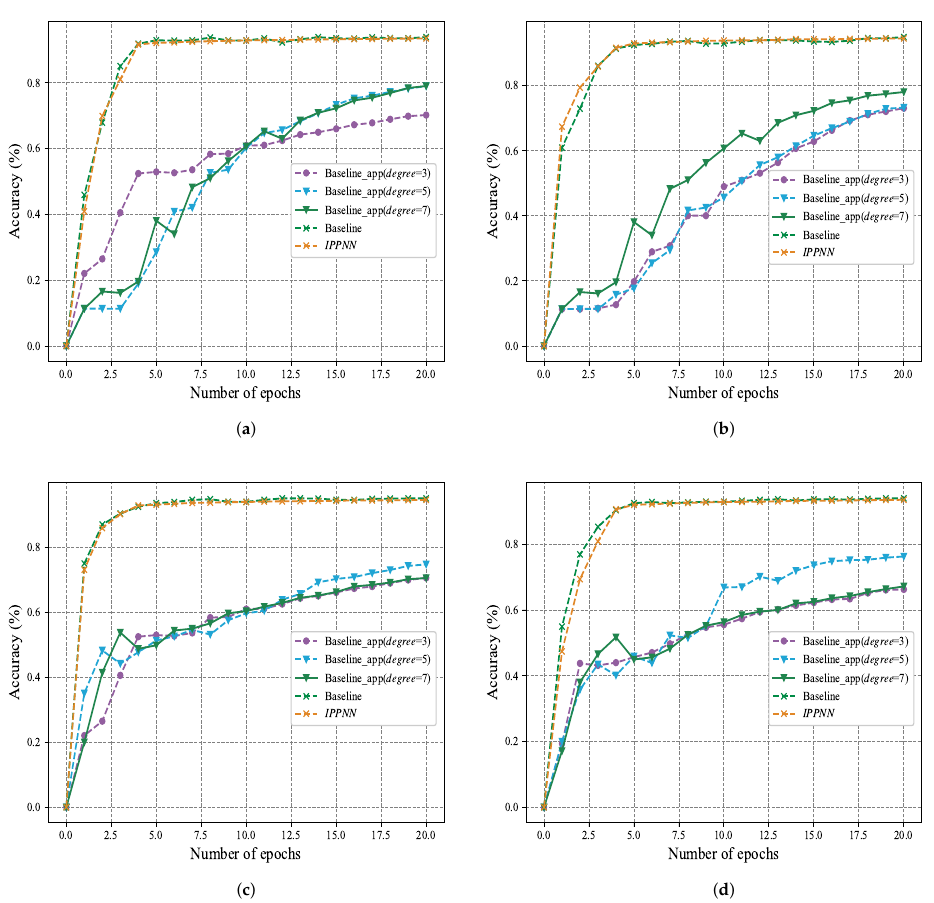
Figure 3. Comparison between IPPNN and Baseline with Taylor approximation in model accuracy (batchsize = 60). ( a ) Accuracy on digits-MNIST ( b = 256). ( b ) Accuracy on digits-MNIST ( b = 128). ( c ) Accuracy on fashion-MNIST ( b = 256). ( d ) Accuracy on fashion-MNIST ( b =